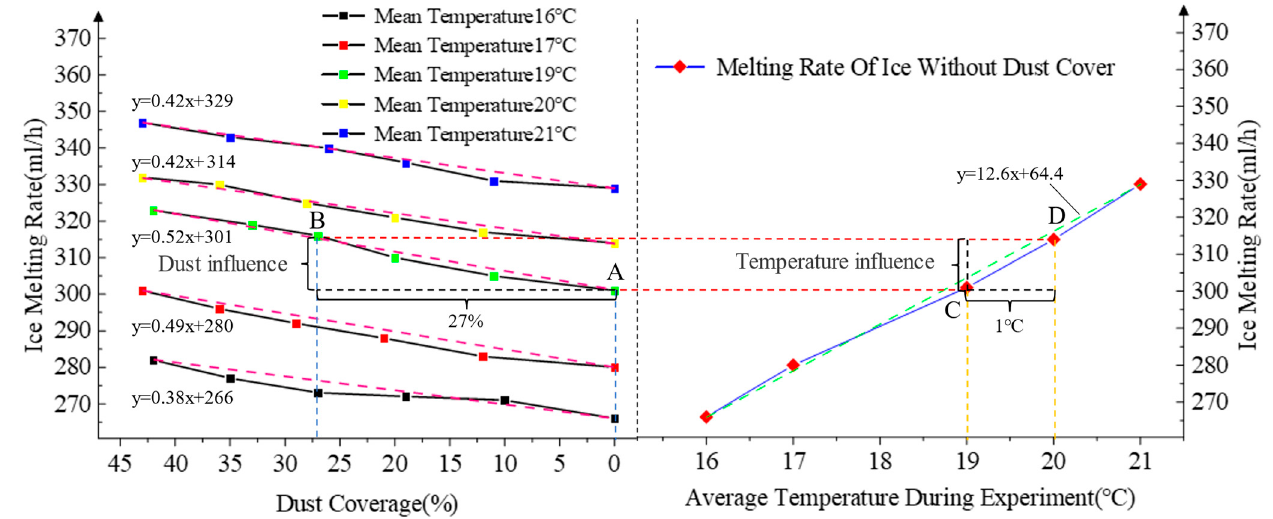
Figure 13. Influence of the dust coverage and the temperature on the ice-melting rates. (1) Influence of dust coverage on the ice-melting rate As shown on the left side of Figure 13, the rate at which glaciers melt increases with the dust cover and the temperature. Generally, the ice-melting rates at different average temperatures demonstrated the same trend, i.e., the average slopes of the plots at different temperatures were approximately the same. The slopes were 0.38, 0.49, 0.52, 0.42, and 0.42